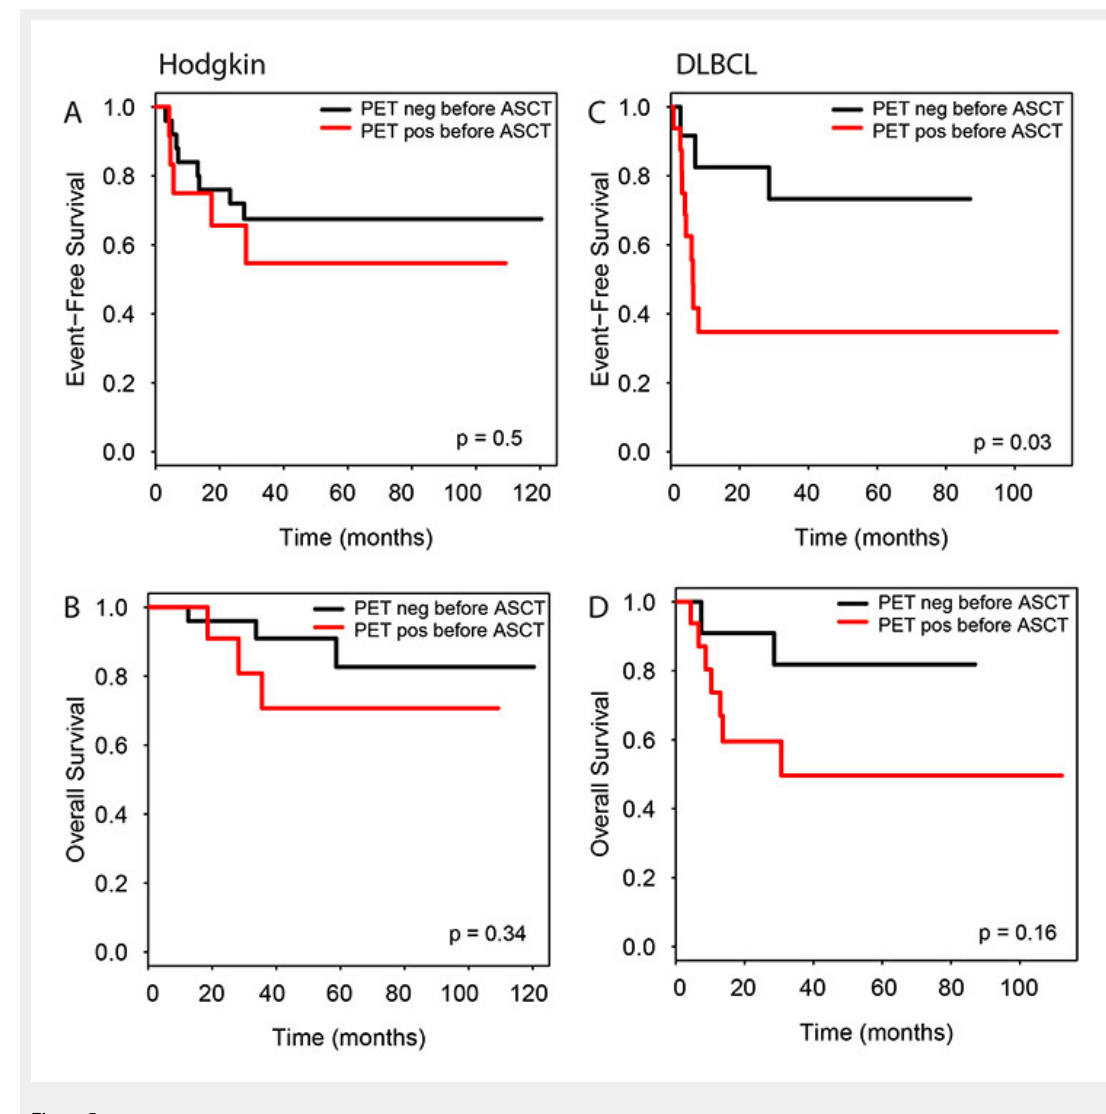
Figure 5 Impact of pre-transplantation PET/CT on event free and overall survival according to lymphoma entity. Hodgkin’s lymphoma (A, B) and DLBCL (C,